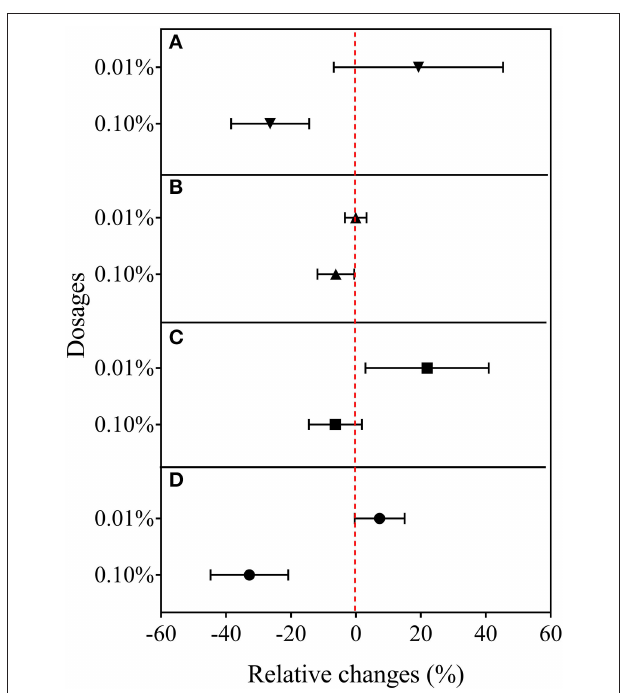
FIGURE 4 | Relative changes in leaf gas exchange capacity in Experiment 2b ( n = 4). (A) Leaf transpiration rate, (B) photosynthetic rate, (C) intercellular CO 2 concentration, and (D) stomatal conductance to water